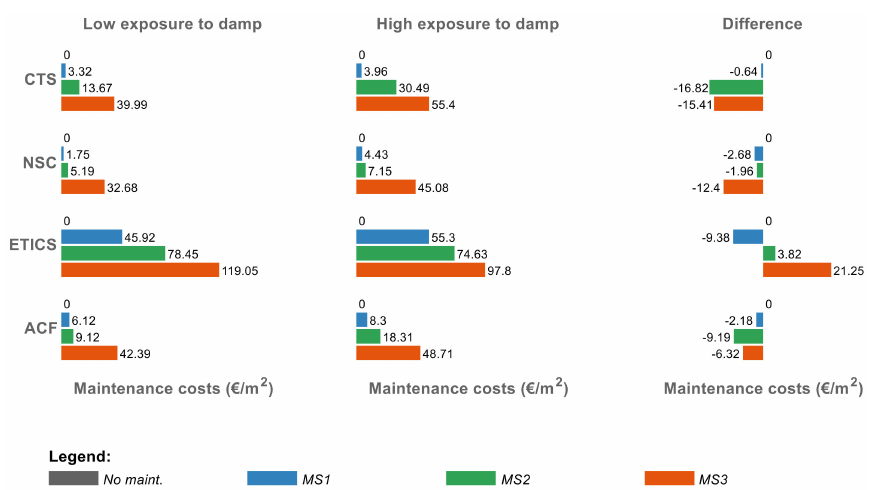
Figure 4. Comparison of the maintenance costs according to exposure to damp for a time horizon of 80 years.